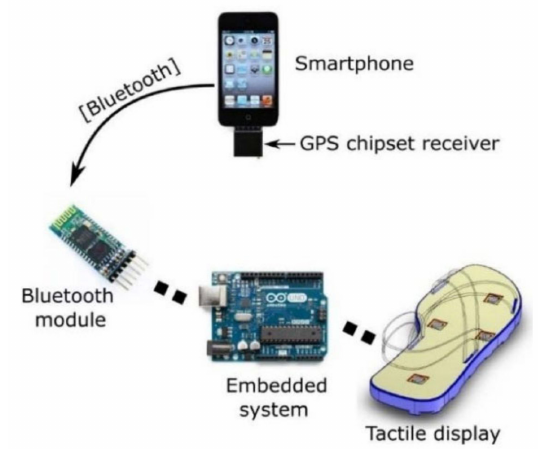
Figure 10. Navigation system with tactile foot feedback